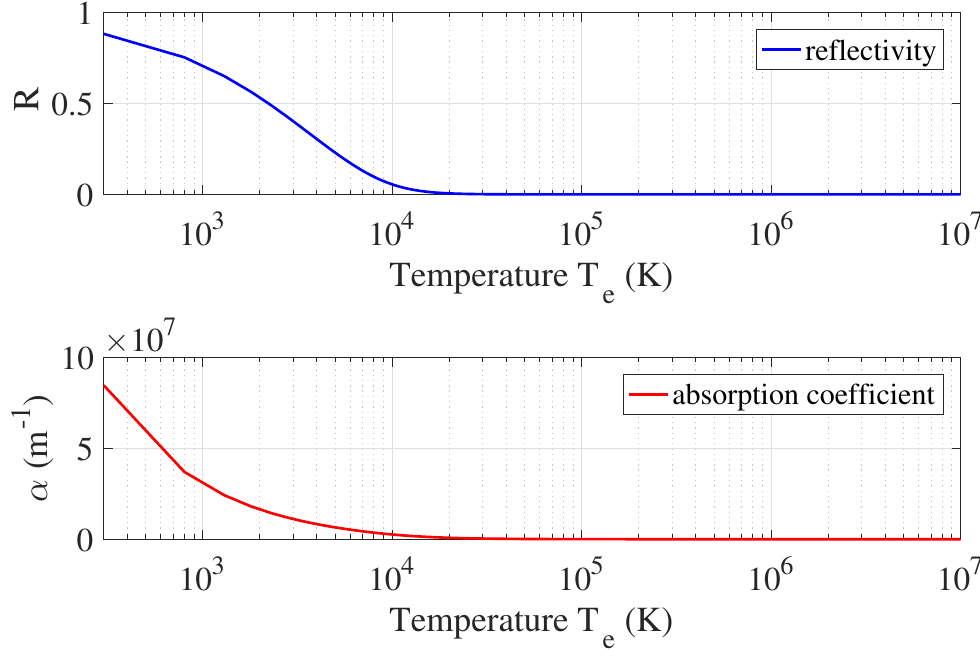
Figure 1. Reflectivity and absorption coefficient versus electron temperature. Note that the x-axis starts at 300